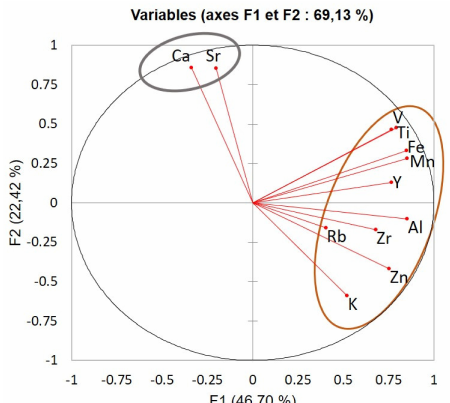
Figure 5. Principal Component Analysis (PCA) showing the relationship between the geochemical elements in response to the environmental gradient. The main two factors of the PCA explain 64.48% and 15.51% of the variance, respectively. In blue, it is the negative loading marine representative marine and in brown, positive loading associated continental deposit.